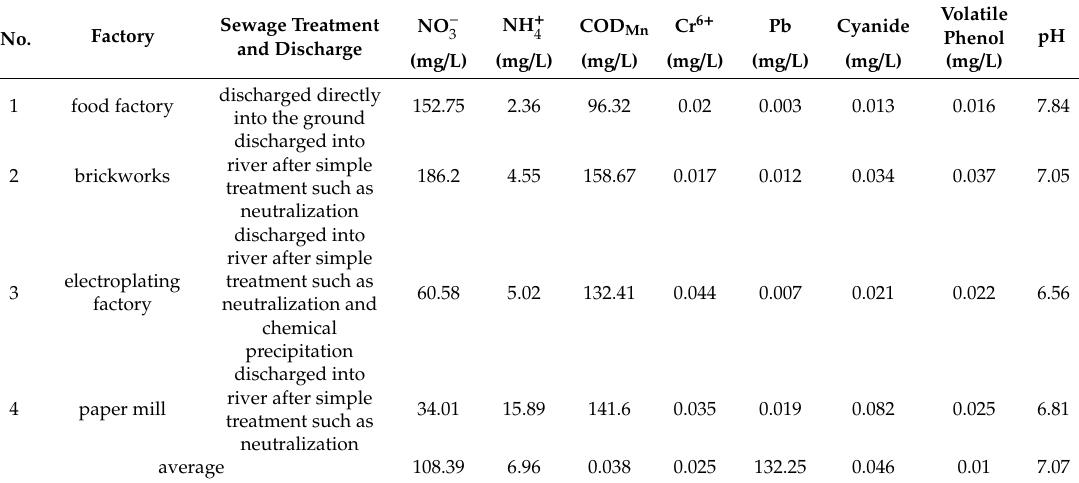
Table 6. Pollutant concentration in factory sewage.